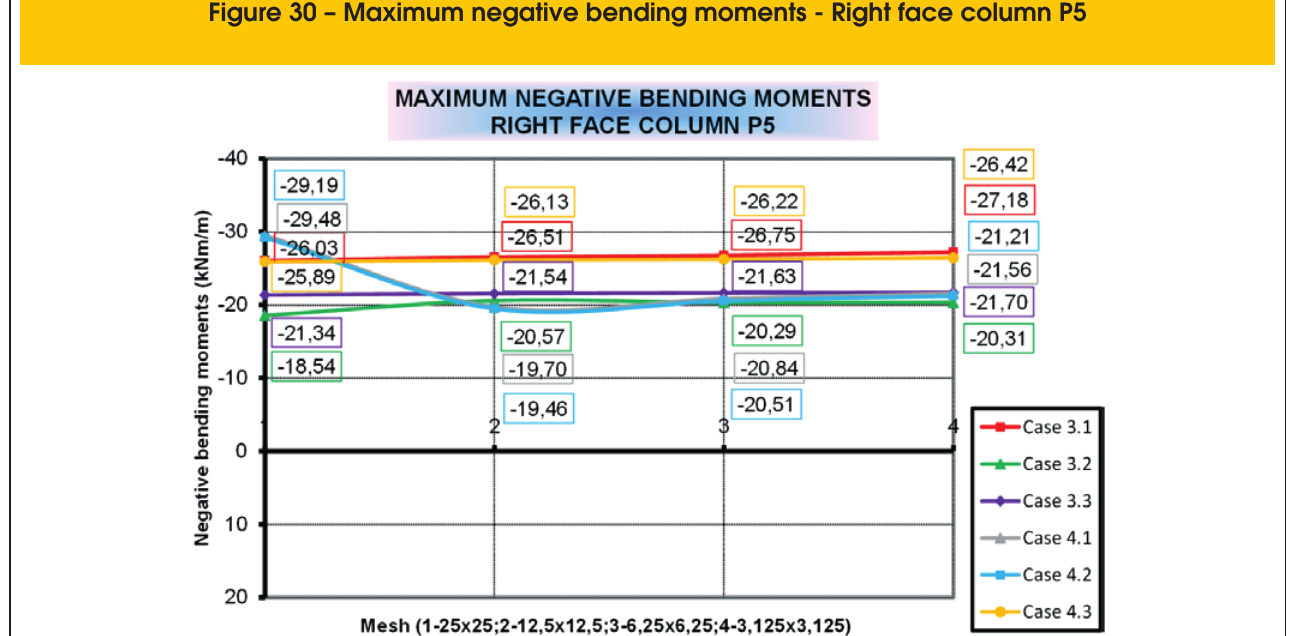
Figure 37b with